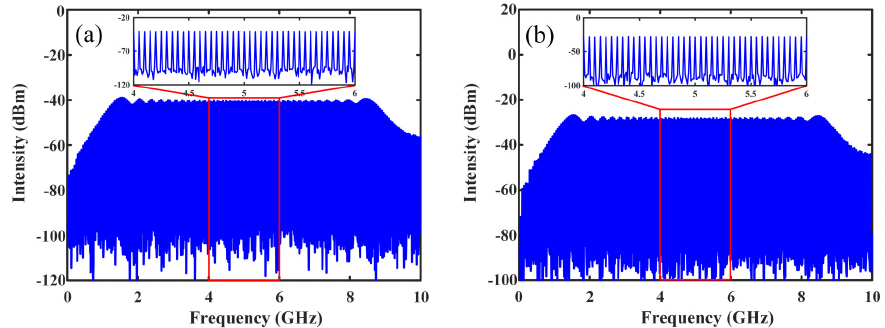
Figure 9. Simulation results for the photonic ADC to digitize a periodic LFM signal within the frequency range of 1 GHz to 9 GHz and with a period of 20 ns. ( a ) Reconstructed spectrum by using the low-speed NPS-based ADC. ( b ) FFT spectrum by using the equivalent high-speed uniform photonic sampling-based